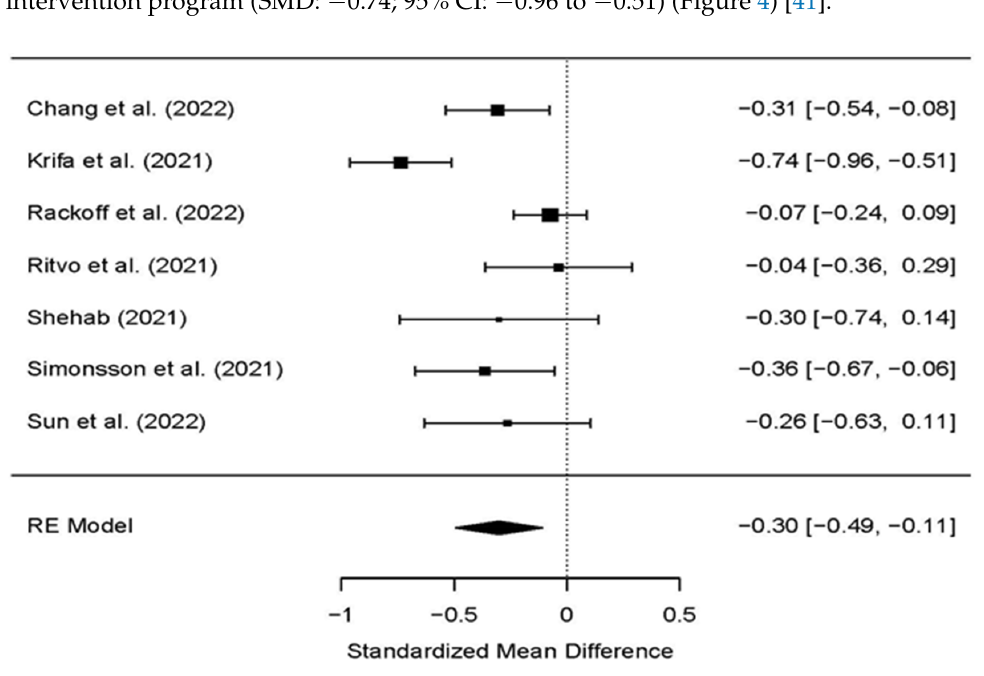
Figure 4. The effects of psychological interventions on reducing depression among university students during COVID-19 in the included randomized controlled trials [32,34–38,41]. As presented in Figure 5b, an almost symmetrical funnel plot of RCTs for diminish- ing anxiety indicated the absence of publication predisposition. The outcomes from Eg- ger’s regression test ( t (7) = − 1.98, p = 0.088) and the Begg–Mazumdar rank correlation test for funnel plot asymmetry (Kendall’s tau = − 0.33, p = 0.256) did not affirm that there was significant asymmetry in the funnel plot. This information shows that publication predis- position was not identified in the meta-analysis of RCTs for decreasing anxiety. The fail- safe N test revealed that the fail-safe number N was robust ( N = 208) and that 208 exami- nations of anxiety decrease were expected to invalidate the significant impact at p > 0.05.